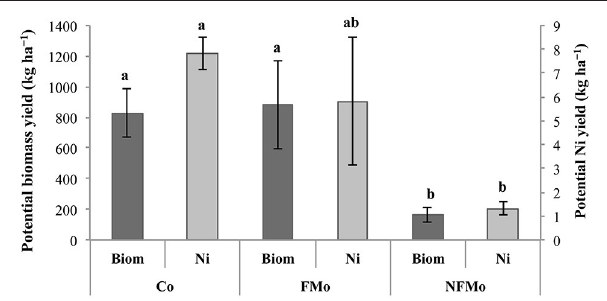
FIGURE 5 | Potential biomass (Biom) and Ni yields (Ni) of Odontarrhena muralis s.l. shoots (kg ha − 1 ). “Co”, “FMo” and “NFMo” correspond to co-cropping with the legume, fertilized mono-cropping, and non-fertilized mono-cropping, respectively. Means ± standard error followed by different letters are significantly different at p < 0.05 (Duncan’s multiple range